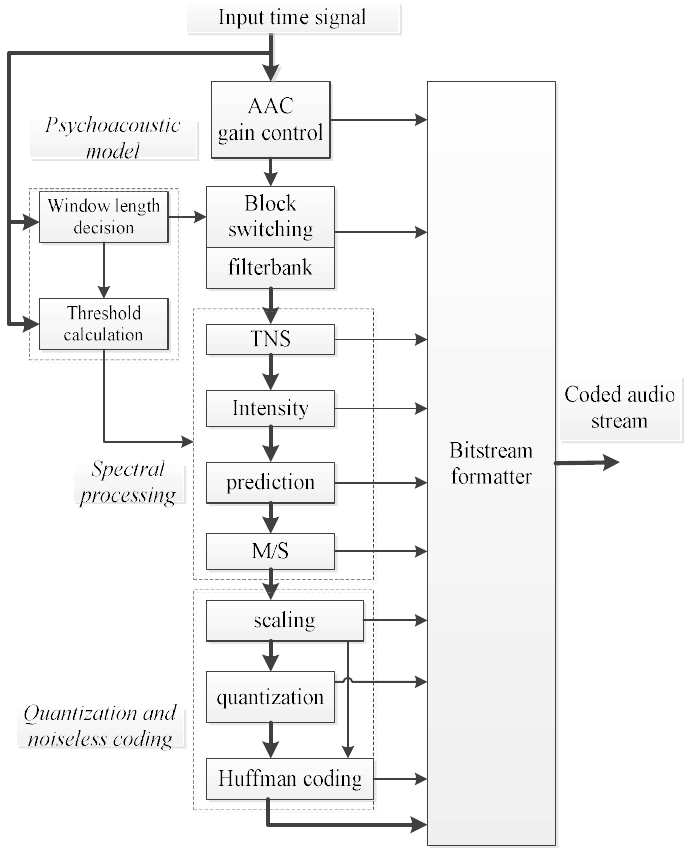
Figure 1. Advanced audio coding (AAC) framework.